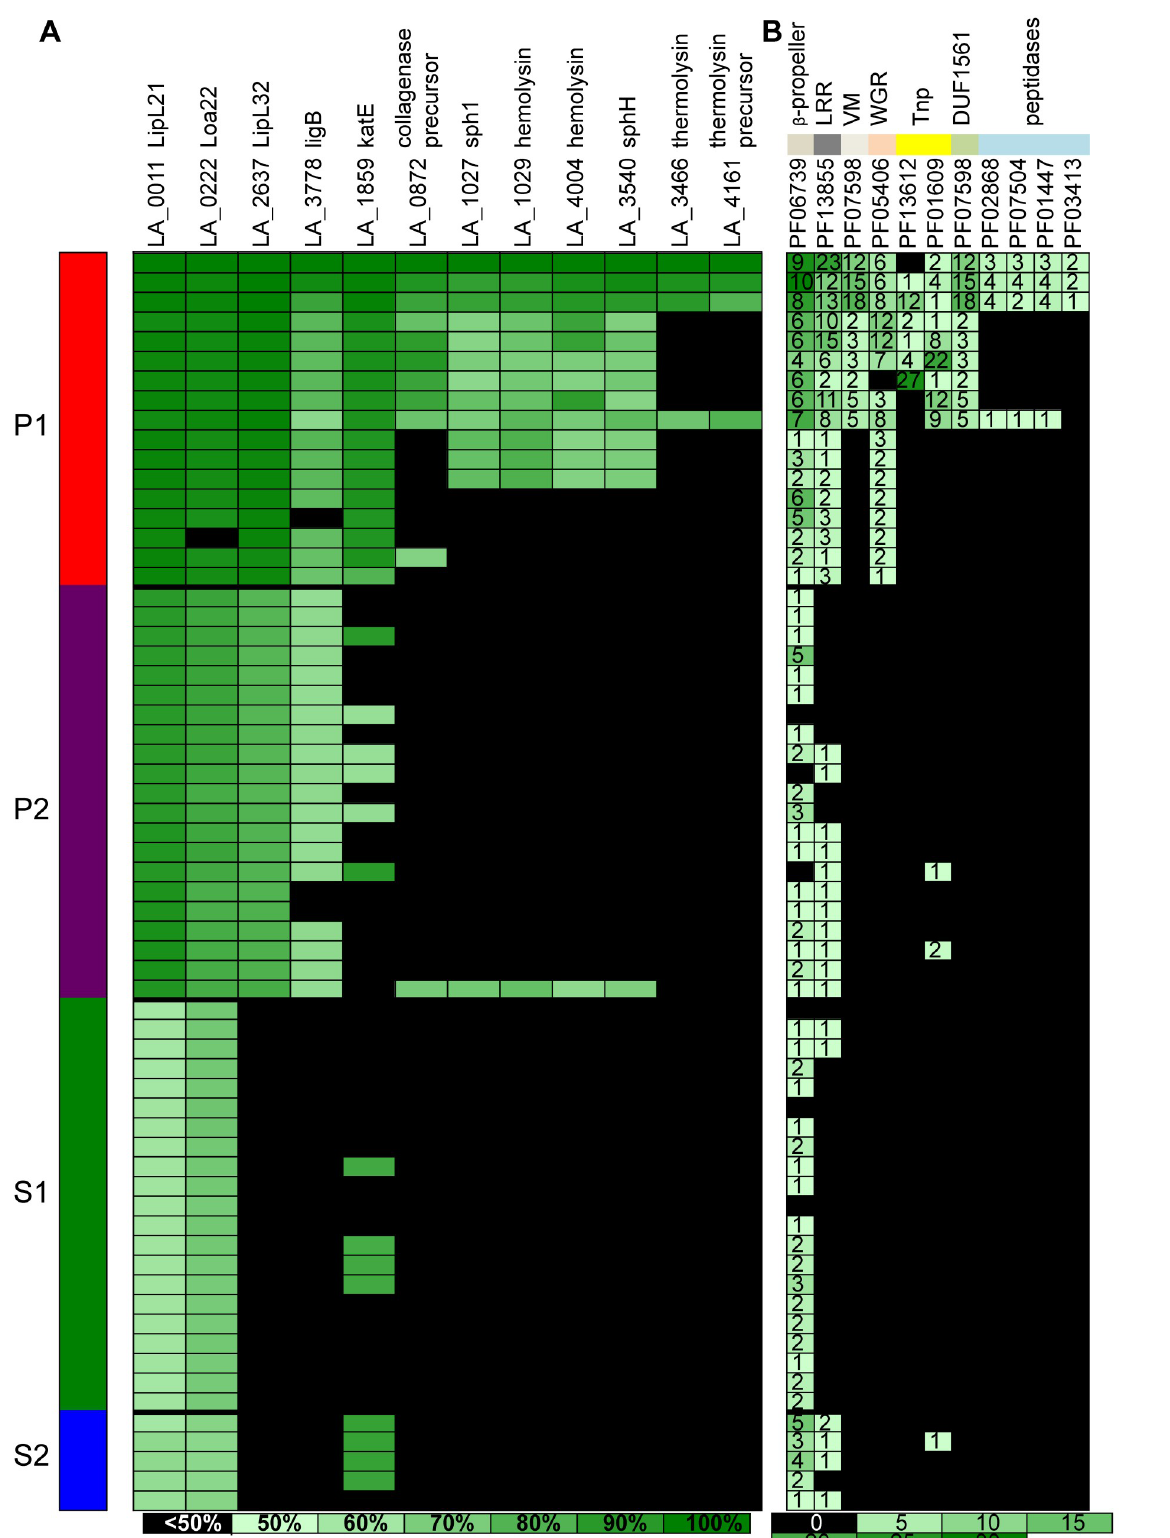
Fig 7. Distribution of genes involved in virulence (A) and PFAM motifs (B). The gradient represents for (A) the percentage of similarity according to the homologous proteins sequences in L . interrogans strain 56601 and for (B) the number of genes having the different PFAM motifs.